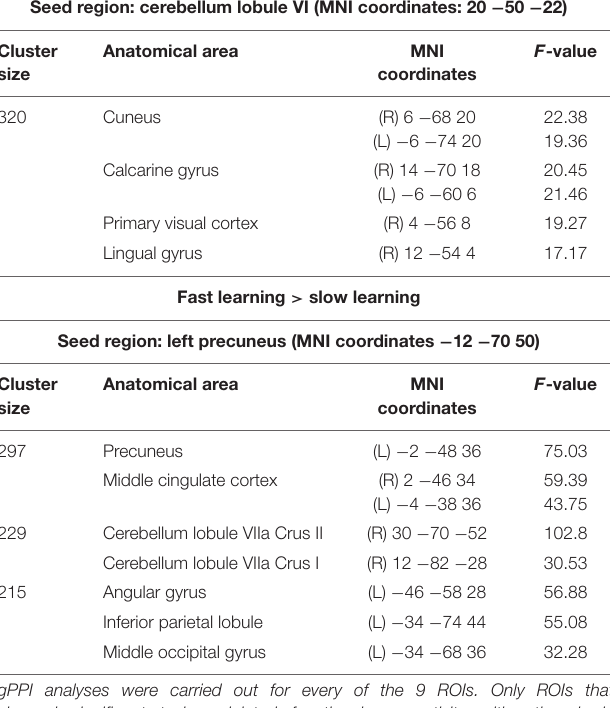
TABLE 3 | Connectivity increases related to motor learning [ p < 0.0055 (after Bonferroni correction), FWE corrected at cluster-level -voxel defining threshold p =